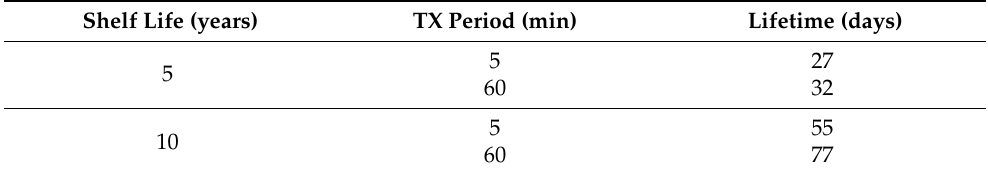
Table 5. Microchip LoRa Mote battery lifetime